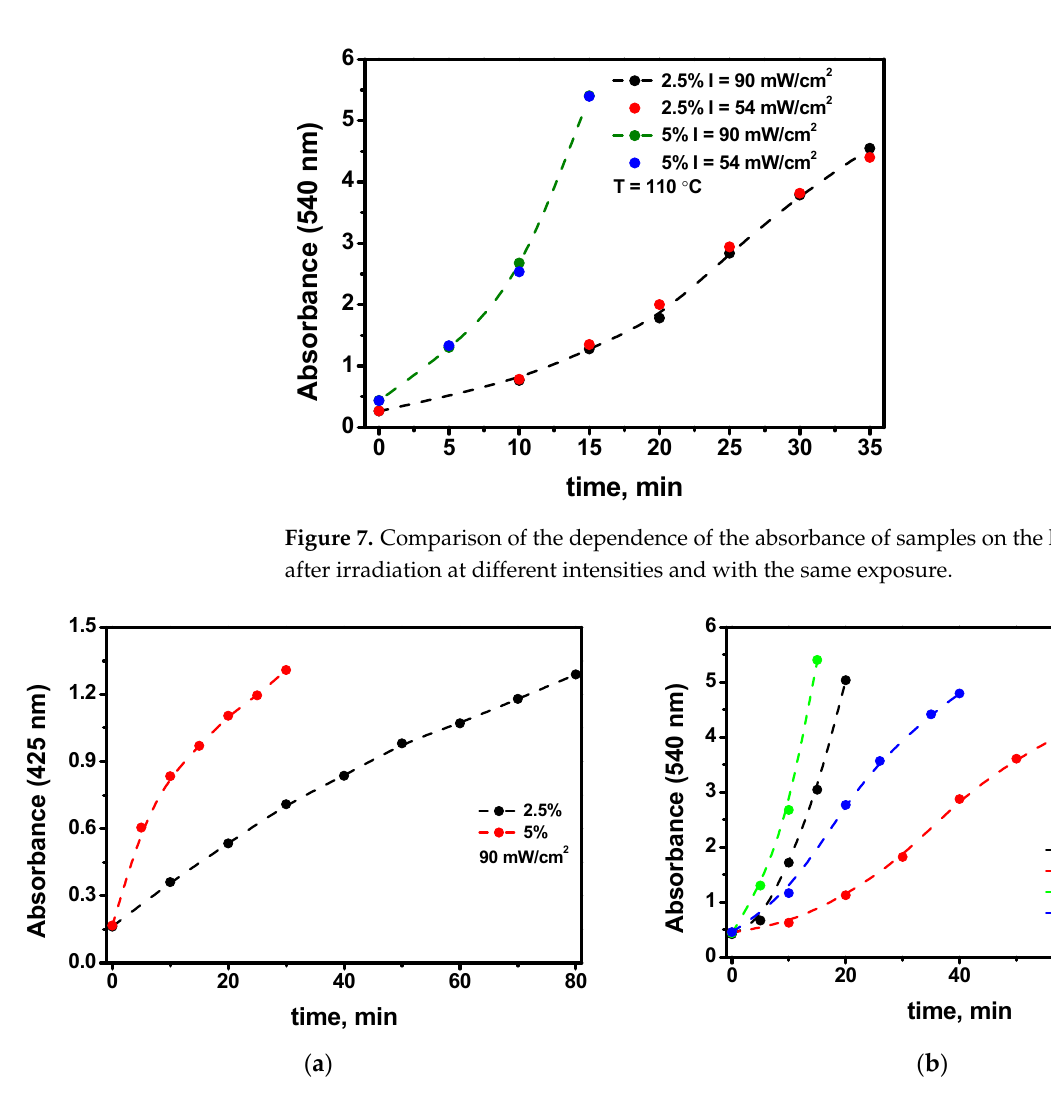
Figure 6. Absorbance of samples polystyrene + (Ph 3 P)Au( n -Bu) 2.5% ( a ) and 5% ( b ) at a wavelength of 540 nm depending on the heating time at four different temperatures.